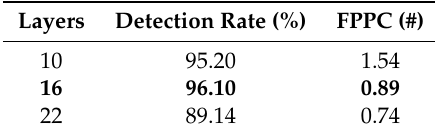
Table 5. Performance evaluation using merged data-set and restricted